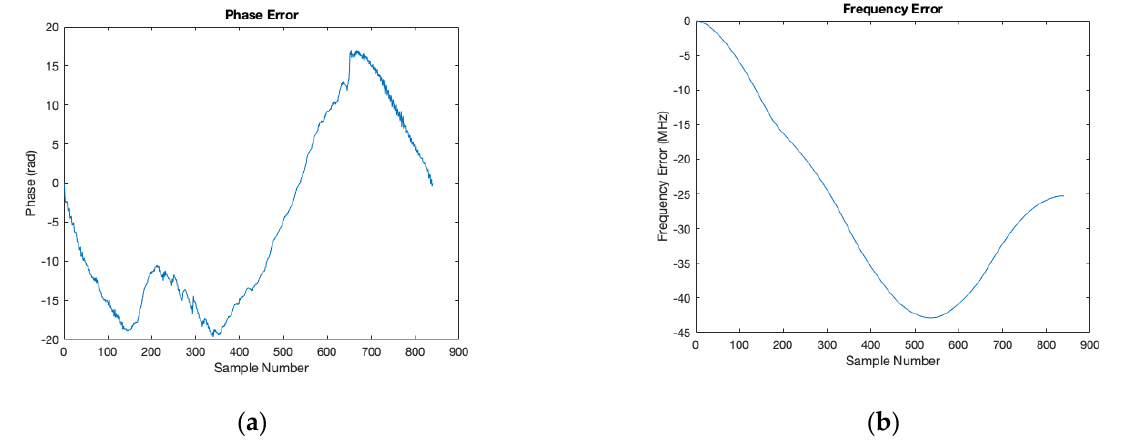
Figure 6. ( a ) Phase error vs. sample number (time) and ( b ) frequency error.